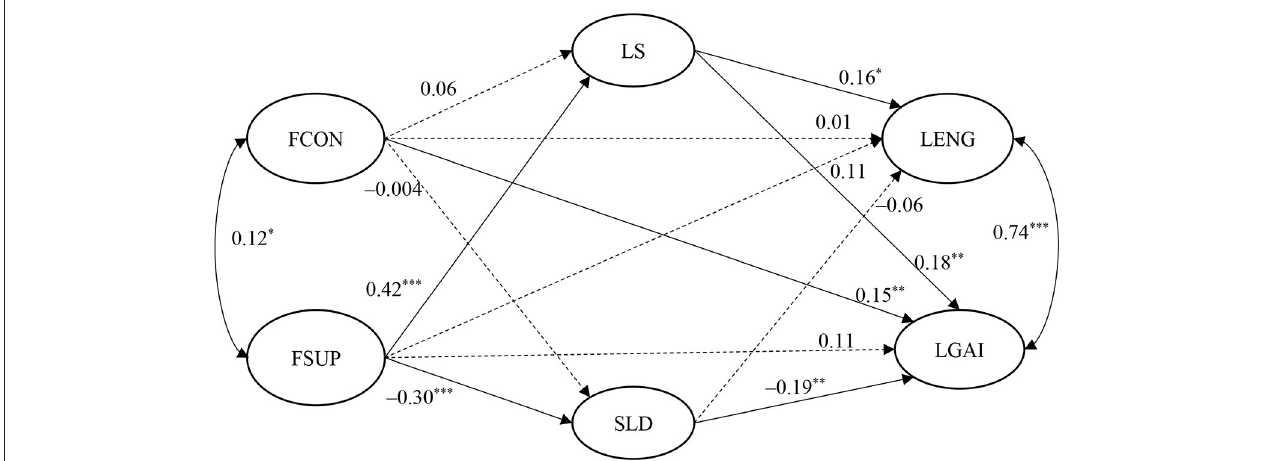
FIGURE 1 | Standardized results of structural equation modeling on the relationships among family wellbeing, individual wellbeing, and learning (residuals and covariates are omitted for parsimony). FCON, family conflict; FSUP, family support; LS, life satisfaction; SLD, sleep difficulties; LENG, learning engagement; LGAI, learning gain. Solid lines indicate significant paths and dotted lines indicate insignificant paths. * p < 0.05, ** p < 0.01, *** p <